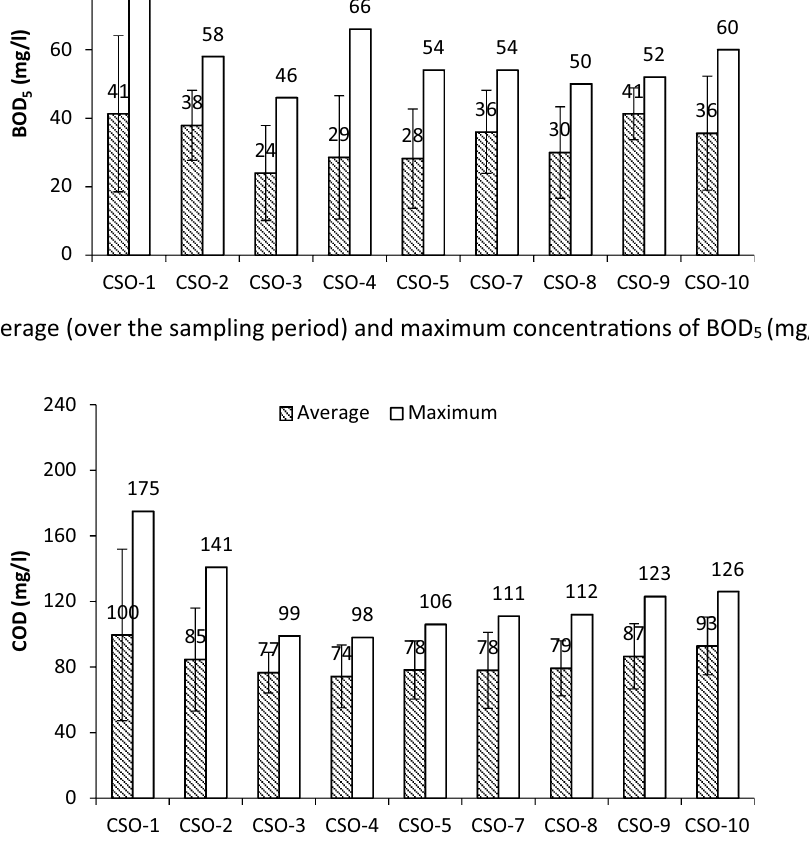
Fig. 2 Average (over the sam- pling period) and maximum concentrations of a BOD (mg/l), and b COD (mg/l), at the 9 sampling locations located close to the 9 CSO structures